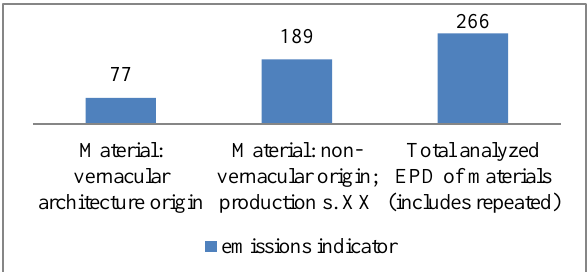
Figure 14. EPD(s) analyzed and validity in Spain.